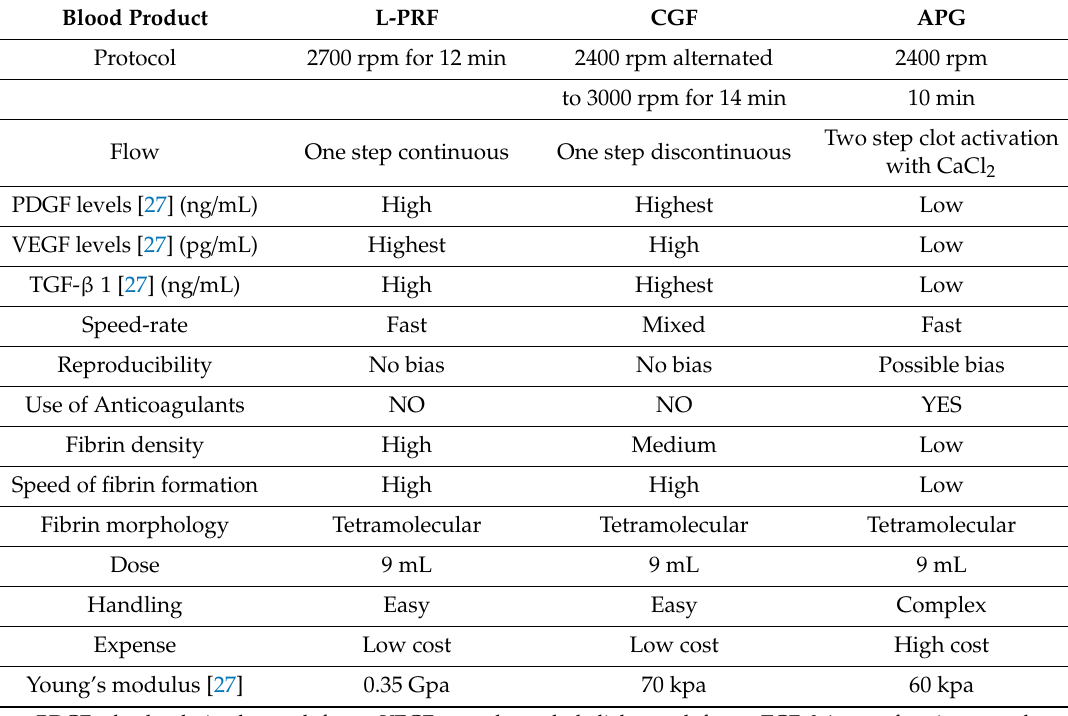
Table 1. Resuming table of the properties of each